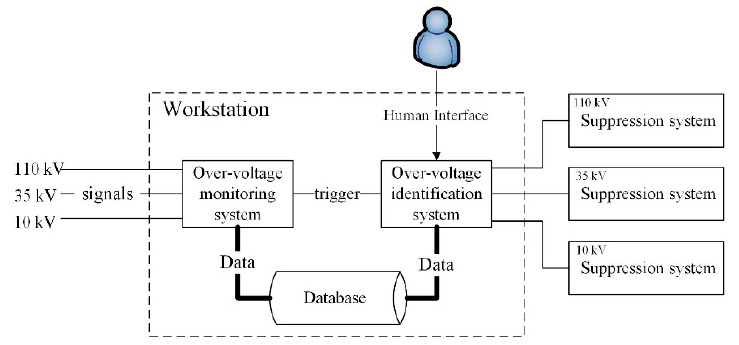
Figure 2. Workflow of overvoltage monitoring-identification system.